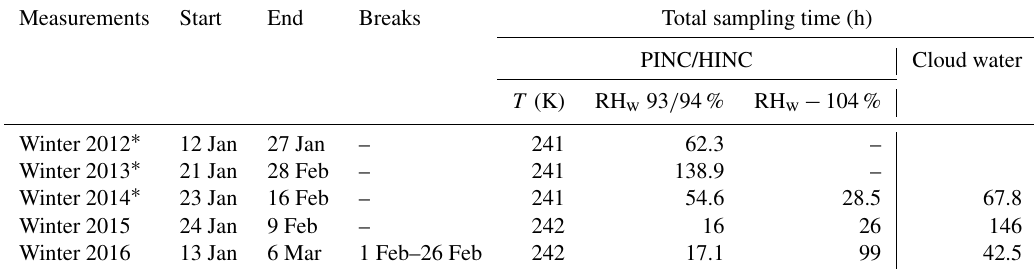
Table 1. Field measurement period and respective total sampling time of INP measurements and cloud water samples. Measurements were performed with PINC (winter 2012–2014) and HINC (winter 2015 and 2016).